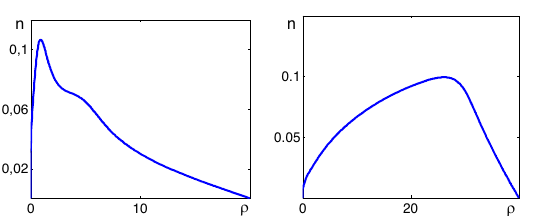
Fig. 2. Similar as in Fig 1 but calculated for less field amplitude in the incident electromagnetic wave ( A